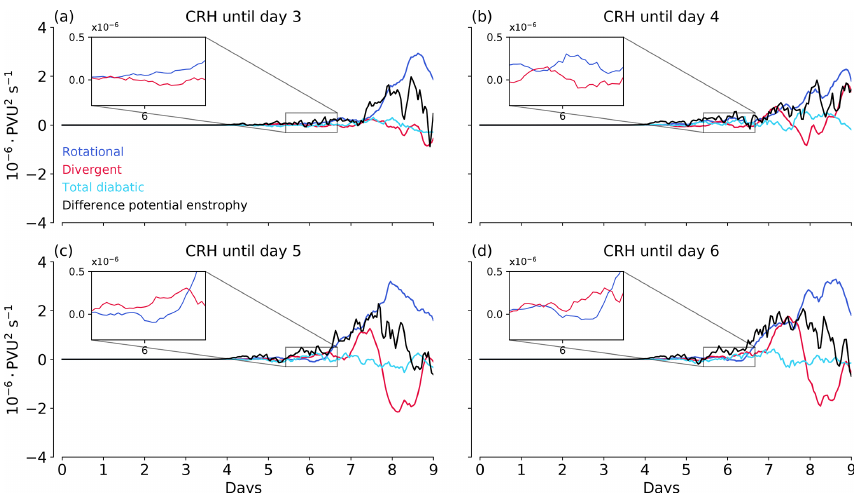
Figure 15. Similar to Fig. 10 but for tendencies calculated from the REF simulation and simulations with CRH disabled at (a) day 3, (b) day 4, (c) day 5 and (d) day